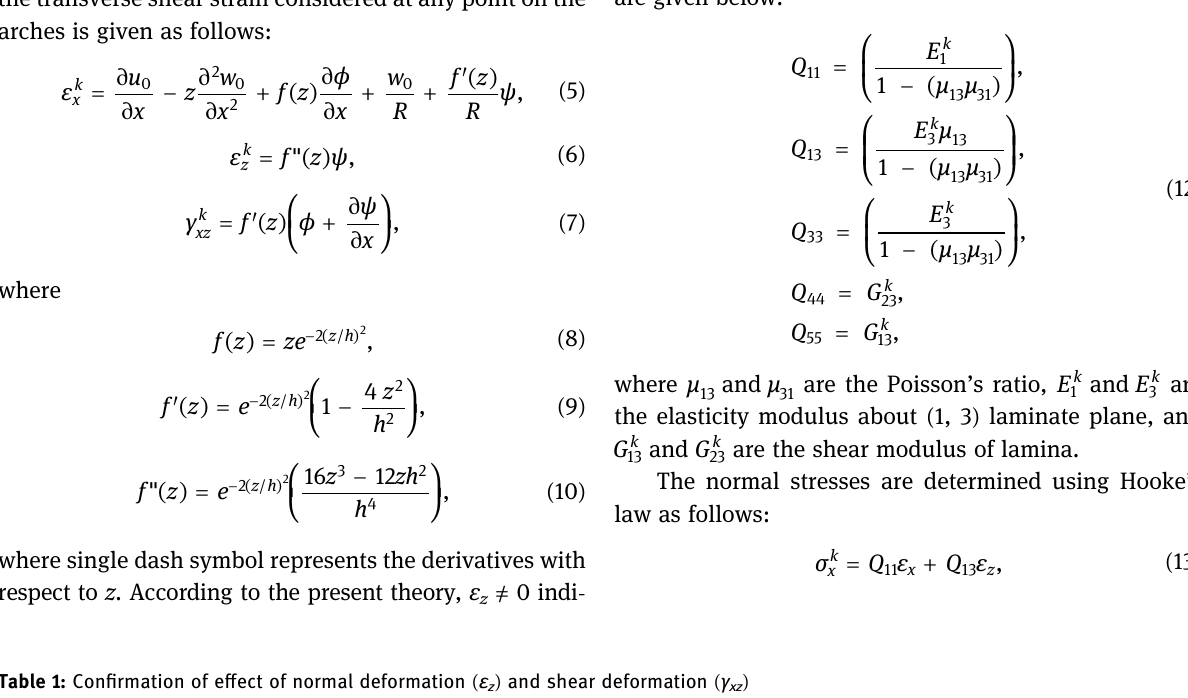
Table 1: Con fi rmation of e ff ect of normal deformation ( ε z ) and shear deformation ( γ xz )